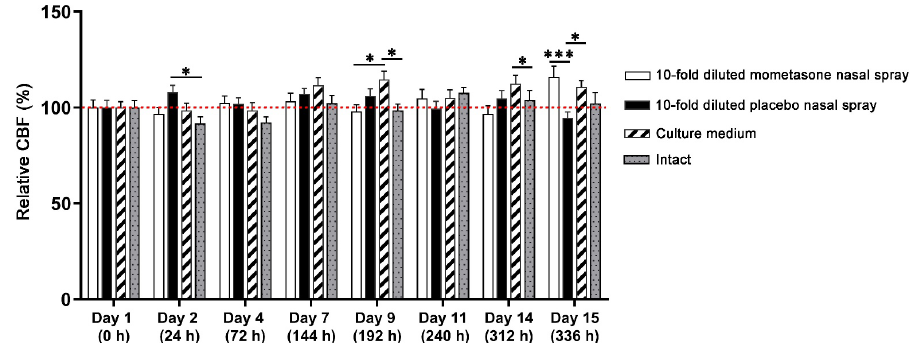
Figure 4. The effect of repeated doses of 10-fold diluted mometasone and placebo nasal spray, culture medium or intact condition on the ciliary beat frequency (CBF) of the nasal MucilAir TM in vitro model. Results are presented as relative CBF values, expressed as a percentage of the CBF values relative to the corresponding baseline control condition for each tested group measured before treatments. The red dotted line represents 100% (the value of the control condition before treat- ment). Each bar represents average relative CBF ± S.E. Diluted mometasone and placebo nasal spray do not inhibit CBF compared to the culture medium-treated and intact nasal in vitro models. Culture medium treatment increases CBF in the second week of daily treatments. n = 50, two-way ANOVA with Tukey’s multiple comparisons test; * p < 0.05, *** p < 0.001.